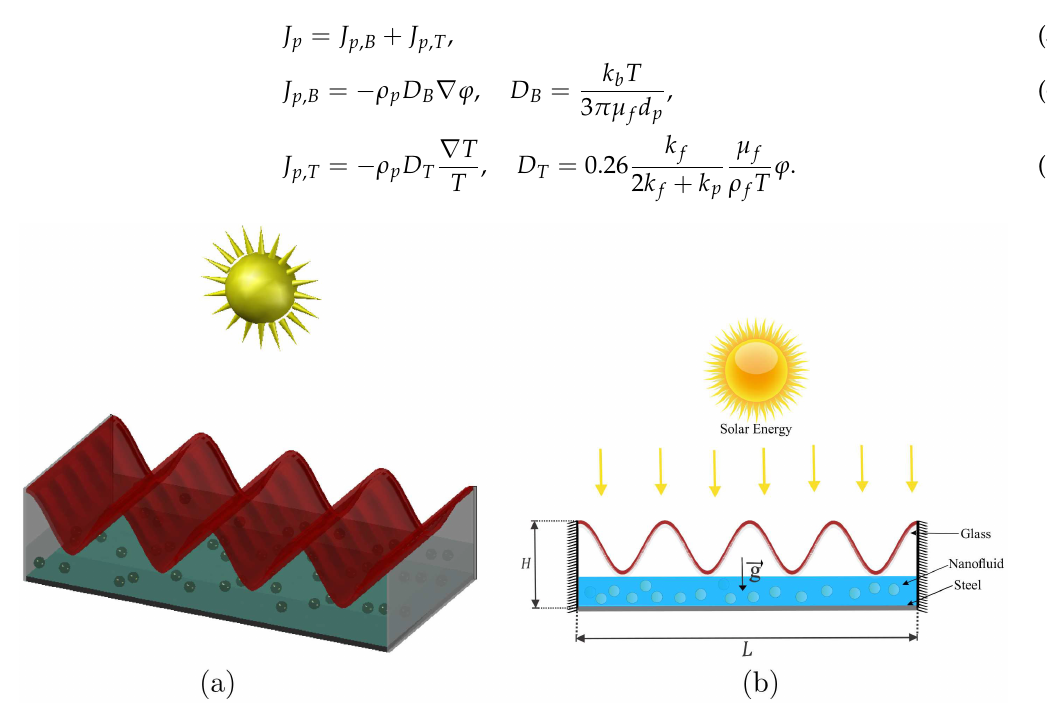
Figure 1. ( a ) 3D-Schematic diagram of the physical model and ( b ) 2D-Schematic diagram in the plane ( x , y